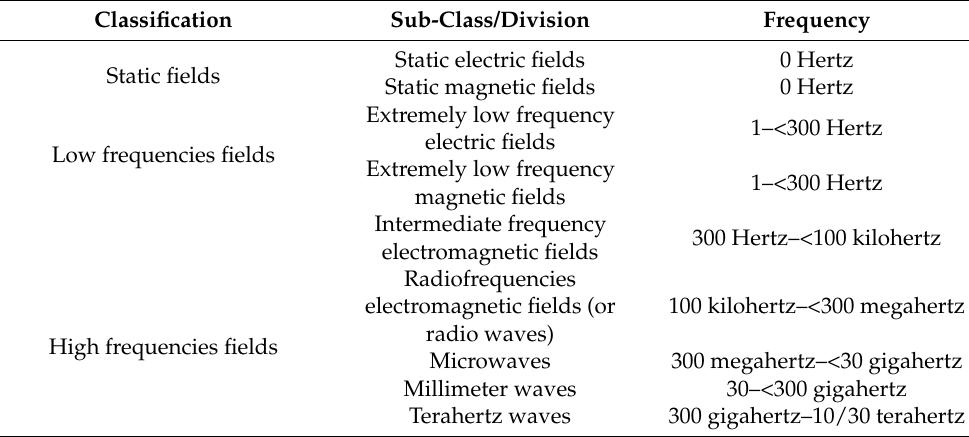
Table 1. Simplified classification of electromagnetic fields relevant for the evaluation of the occupa- tional exposure